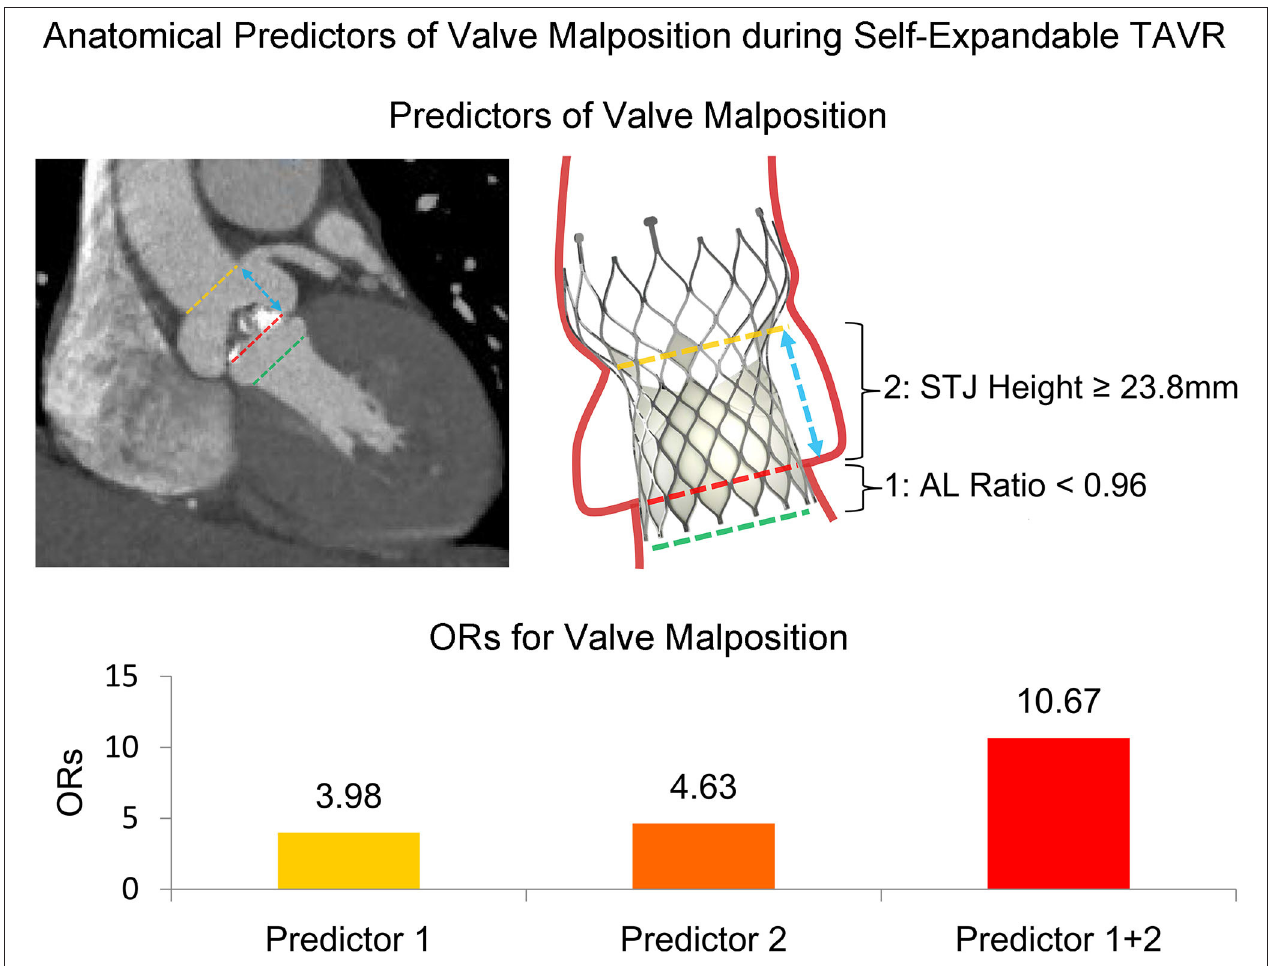
FIGURE 3 | Anatomical predictors of valve malposition during self-expandable transcatheter aortic valve replacement. The dash lines indicate the planes of STJ, annulus, and LVOT. The arrow indicates STJ height. AL, annulus perimeter/LVOT perimeter; LVOT, left ventricular outflow tract; OR, odds ratio; STJ, sinotubular junction; TAVR, transcatheter aortic valve